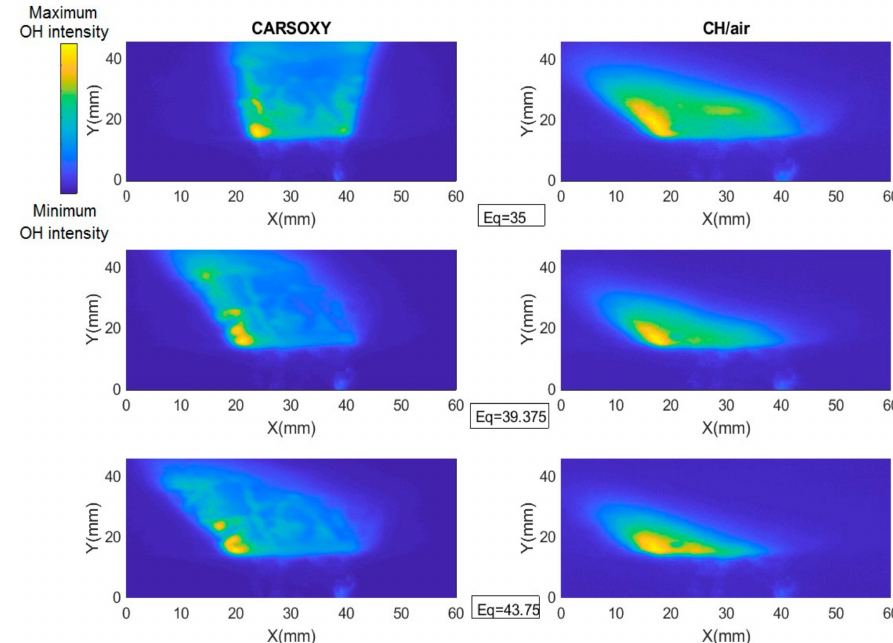
Figure A2. Chemiluminescence sample images at λ oxy = [ 35 − 43.75 ]